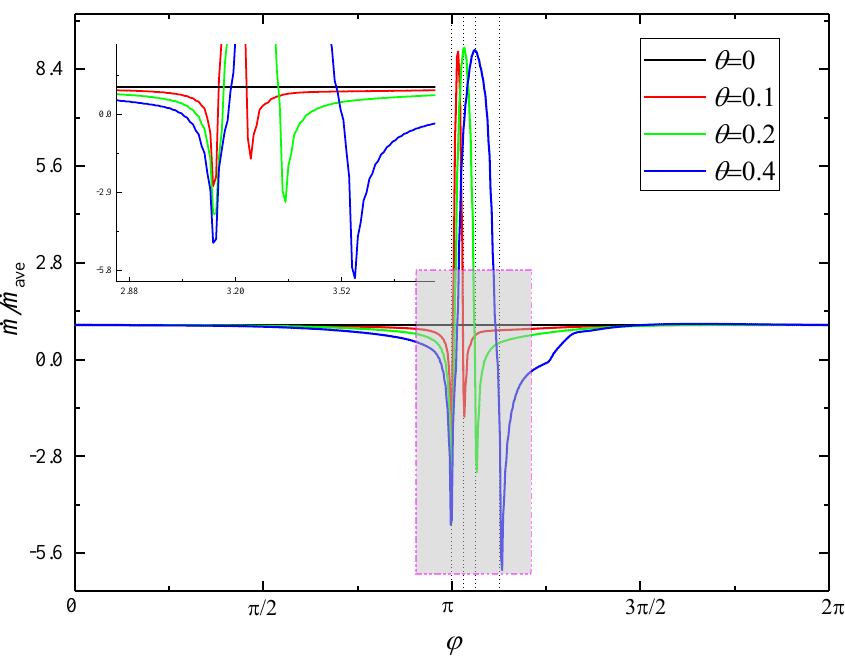
 . Figure 16. Distribution of mass flow rate for 𝐶 𝑤 = 10,137 , 𝑅𝑒 𝜑 = 5.12 × 10 5 , 𝐸 = 0.2 at r / b = 1.